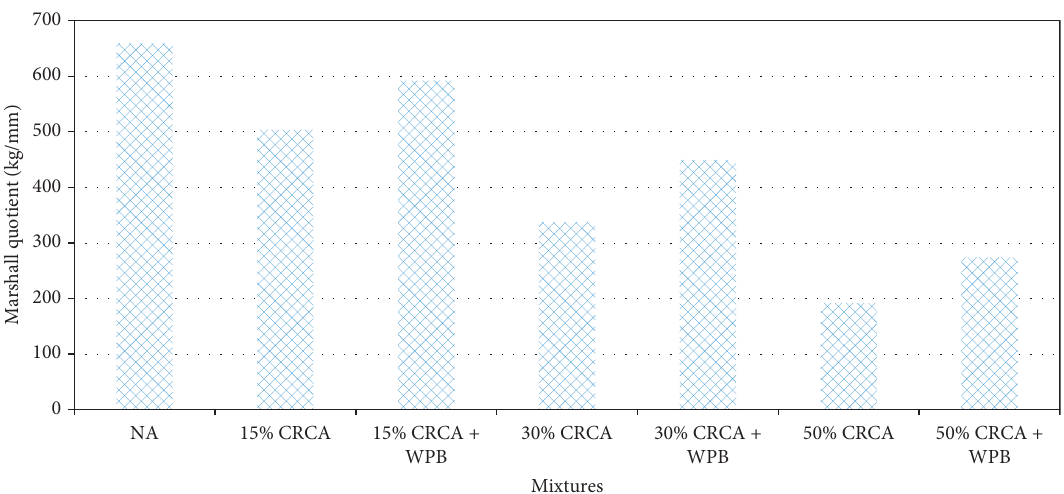
Figure 3: Marshall quotient values for control and modified asphalt concretes.